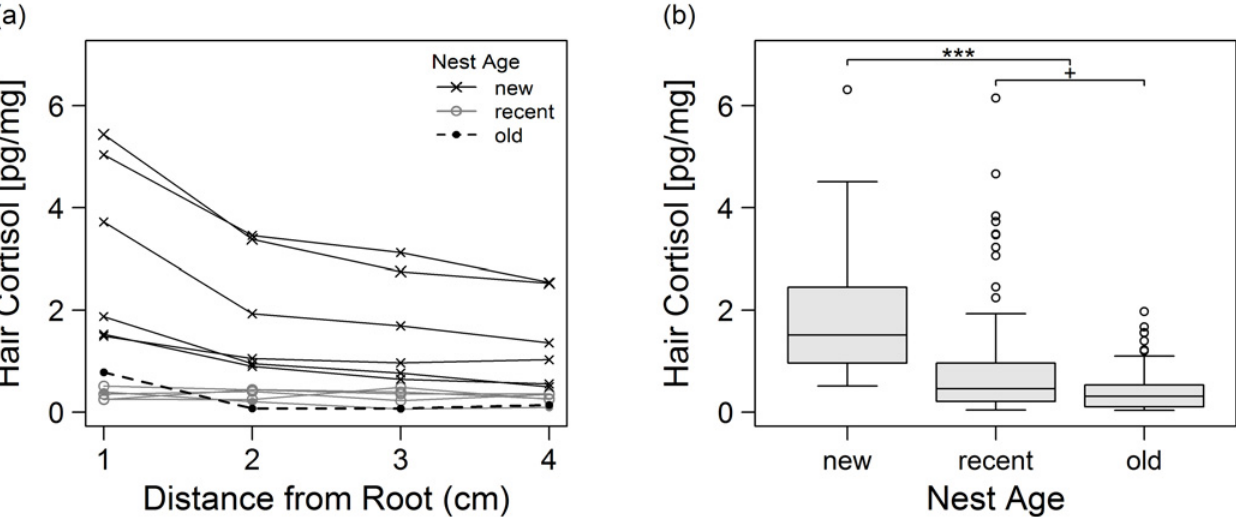
Fig 1. Illustration of (a) waning and (b) nest age effect on hair cortisol concentration. (a) Line plot illustrating hair cortisol concentrations (HCC) along four consecutive 1-cm-segments. Data are shown for a representative subsample from 12 chimpanzee sleeping nests with different nest age classes. HCC was significantly different between segments [ χ 2 (3) = 27.7, p < 0.0001, r 2 = 0.07] with HCC decreasing towards the distal end of the hair shaft. (b) Boxplots with 1.5 IQR showing HCC from 181 sleeping nests depending on the age class of the nest during hair sampling. Planned contrasts indicated that HCC was significantly higher in new vs. recent and old nests [ t (2) = 6.3, p < 0.0001, r 2 = 0.95] whereas HCC was only borderline significant between recent and old nests [ t (2) = 1.85, p = 0.07, r 2 =